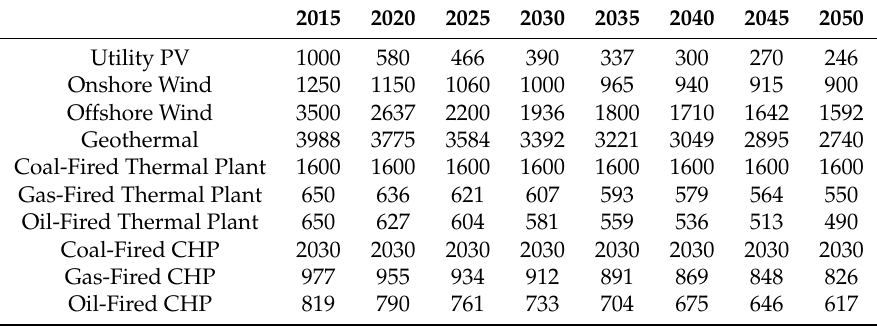
Table A2. Capital Costs of main electricity generating technologies in M e /GW. Data based on Carlsson et al. [30], Basis [31], Gerbaulet and Lorenz [32], Ram et al. [33] and Burandt et al. [34].